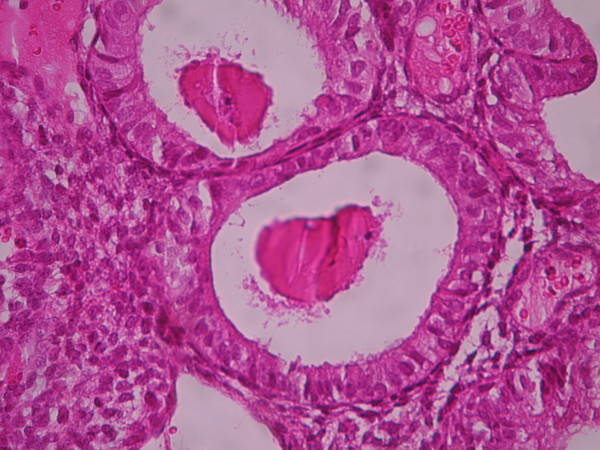
Complex hyperplasia. The glands are separated by scant endometrial stroma from each other. The nuclei are uniform and oval. (High power).